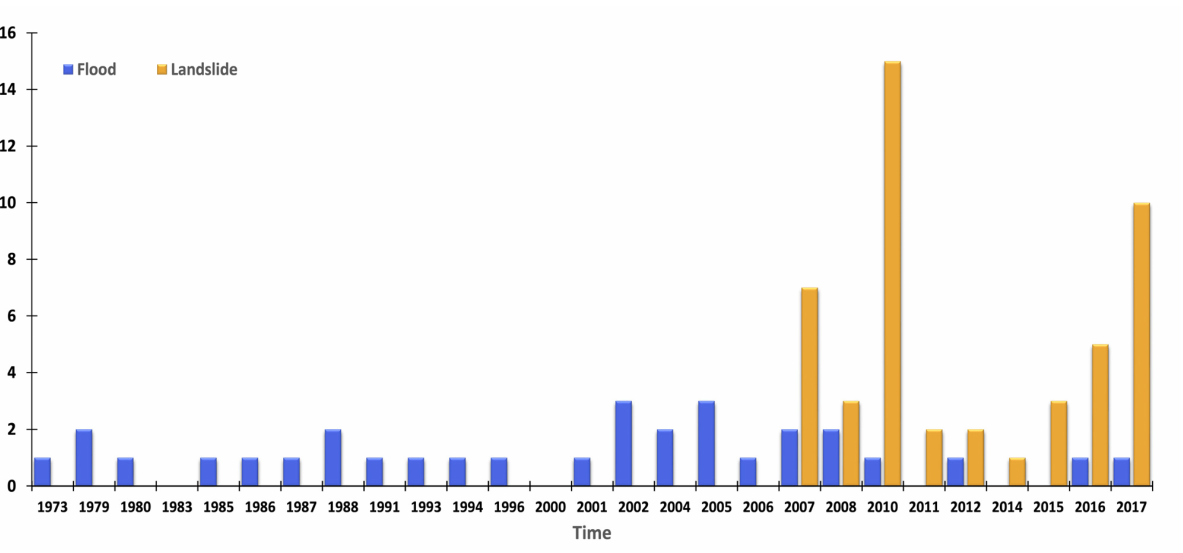
Figure 3. Floods 1973–2017 derived from the EM-DAT database, and Landslides 2007–2017 from the NASA Global Landslide Catalog. Note that inventories for both disasters have different collection start